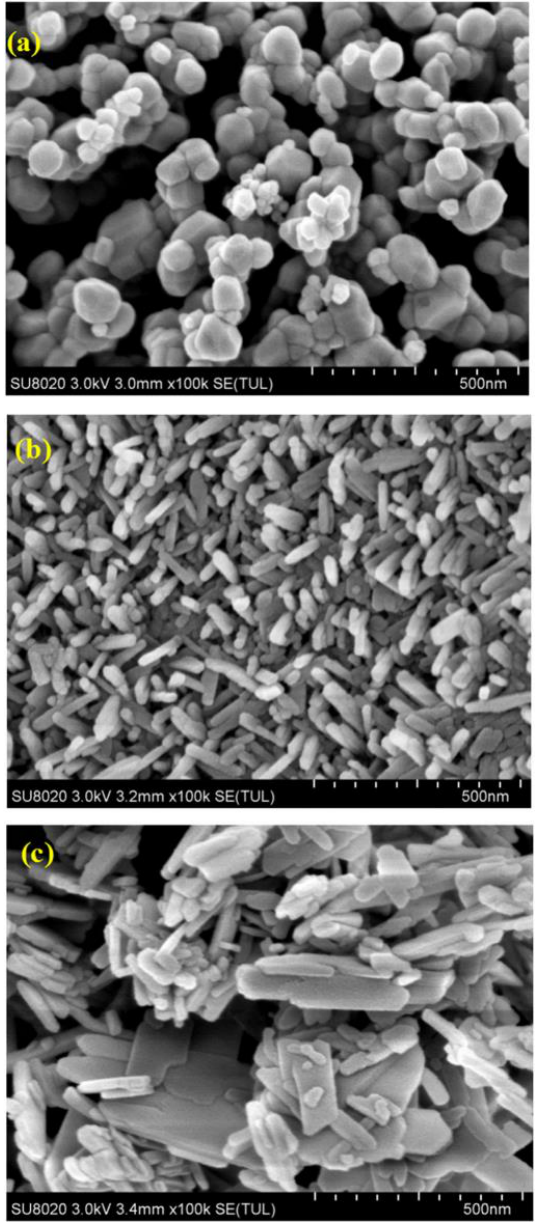
Figure 3. SEM morphologies of CuO nanoparticles with shapes of ( a ) spherical, ( b ) rod, and ( c ) flake [43]. ( c ) flake